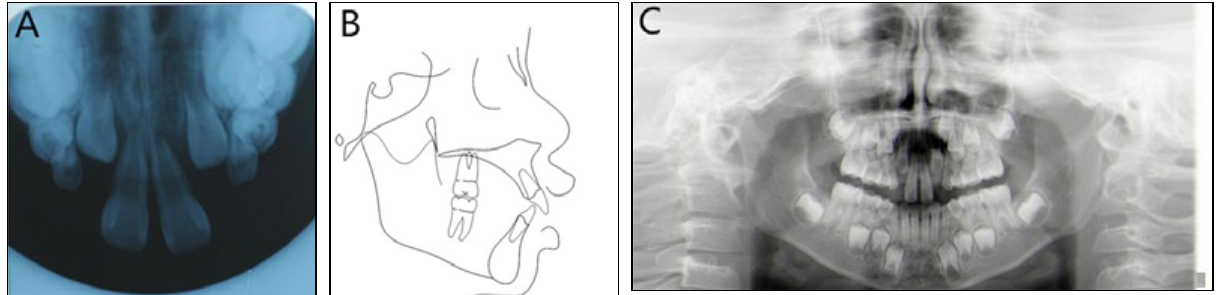
Figure 2. Phase one pretreatment radiographs and cephalometric